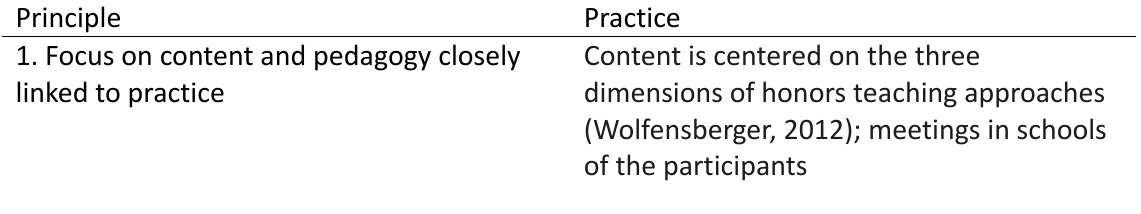
Table 2. Design Principles and the translation to practice